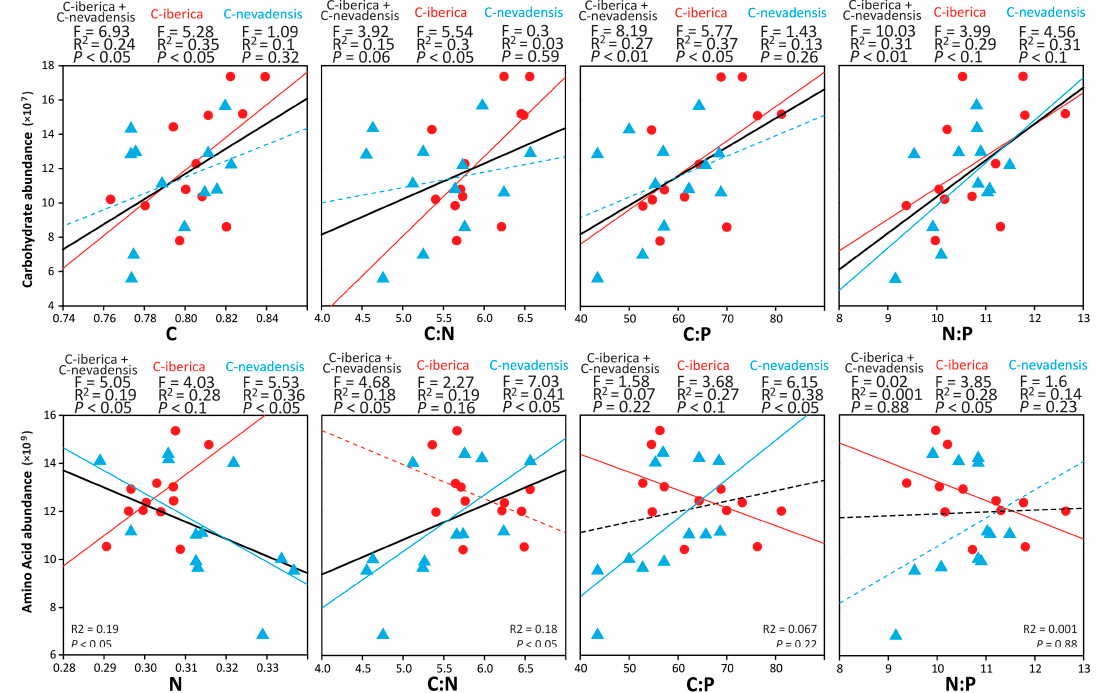
Figure 3. Pearson lineal correlations between total carbohydrate abundance versus C, C:N, C:P, and N:P ratios, and total amino acid abundance versus N, C:N, C:P, and N:P for both caterpillar groups (C-nevadensis and C-iberica) separately ( n = 12) and together ( n = 24). Coefficient of determination ( R 2 ), statistic Fisher value (F), and p value ( p ) are shown. Data corresponding to caterpillars feeding on Pinus sylvestris ssp. iberica (C-iberica) are shown in blue triangles and caterpillars feeding on Pinus sylvestris ssp. nevadensis (C-nevadensis) are shown in red circles. Lineal correlations for C-iberica and C-nevadensis are shown in blue and red, respectively. Lineal correlations for both C-iberica and C-nevadensis are shown in black. Correlations with P > 0.1 are represented by dashed lines.